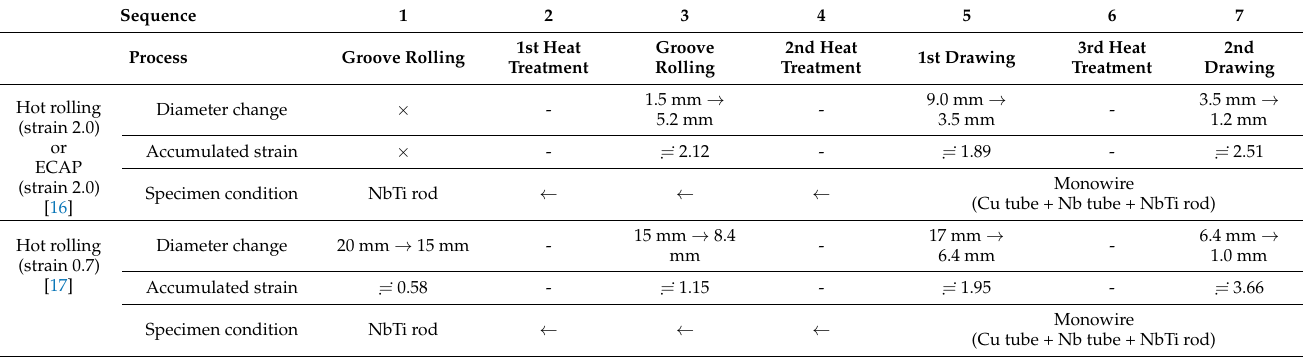
Table 2. Experimental procedure of deformation processes and heat